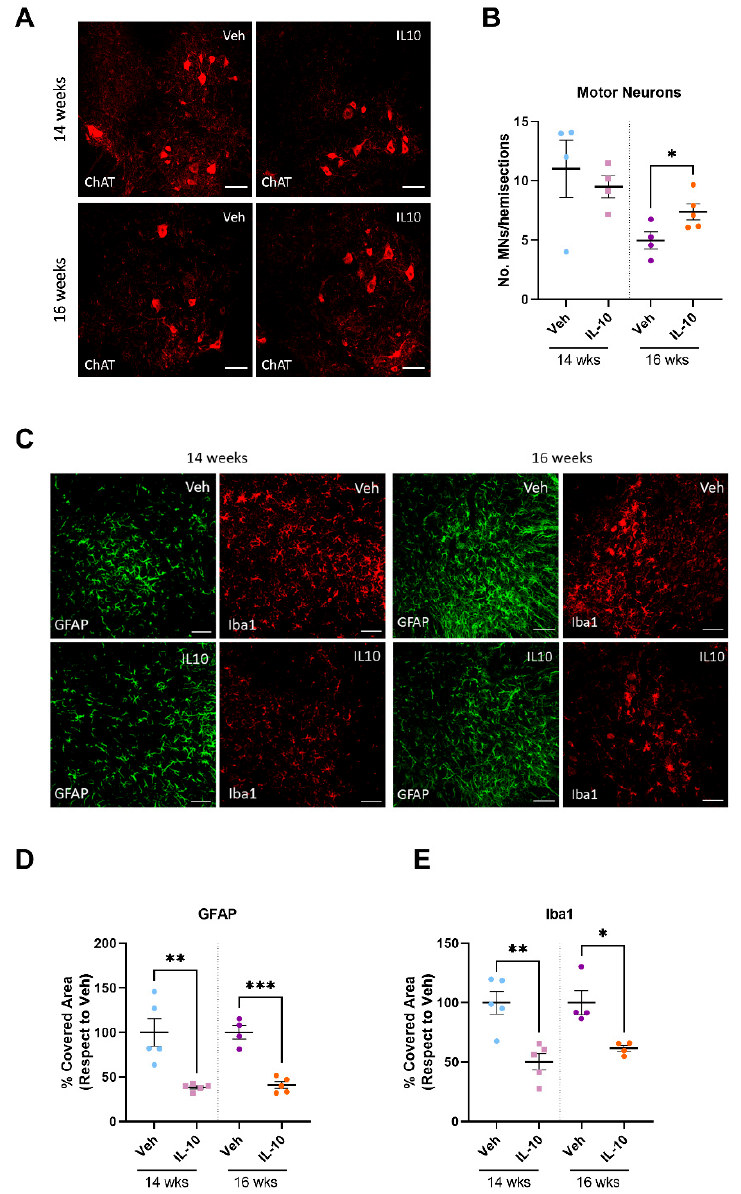
Figure 6. Intramuscular IL-10 administration promotes spinal motor neuron survival and decreases neuroinflammation in the spinal cord of C57-SOD1G93A mice. ( A ) Representative confocal images of Chat-immunostained lumbar spinal cord transverse sections of IL-10- and PBS-treated C57- SOD1G93A mice at 14 and 16 weeks of age. Scale bar = 100 µ m. ( B ) Quantification of MNs Chat+ in the spinal cords of IL-10- and PBS-treated C57-SOD1G93A mice at 14 weeks of age. The data are expressed as mean ± SEM of MNs ( ≥ 400 µ m 2 ) per hemisection. Each symbol in the graph is the average quantification of at least ten serial sections (i.e., 10 hemisections) for each animal. * p < 0.05 by unpaired t -test. ( C ) Representative confocal images showing GFAP (green) and Iba1 (red) staining in lumbar spinal cord transverse sections of IL-10- and PBS-treated C57-SOD1G93A mice at 14 and 16 weeks of age. Scale bar = 100 µ m. ( D , E ) Quantification of the percentage of covered area for GFAP ( D ) and Iba1 ( E ) immunostaining in the spinal cords of IL-10- and PBS-treated C57-SOD1G93A mice at 14 weeks of age. The data are expressed as mean ± SEM. * p < 0.05, ** p < 0.01, *** p < 0.001 by unpaired t -test. Each symbol in the graph is the average quantification of at least five sections (i.e., No. 10 hemisections) for each animal.